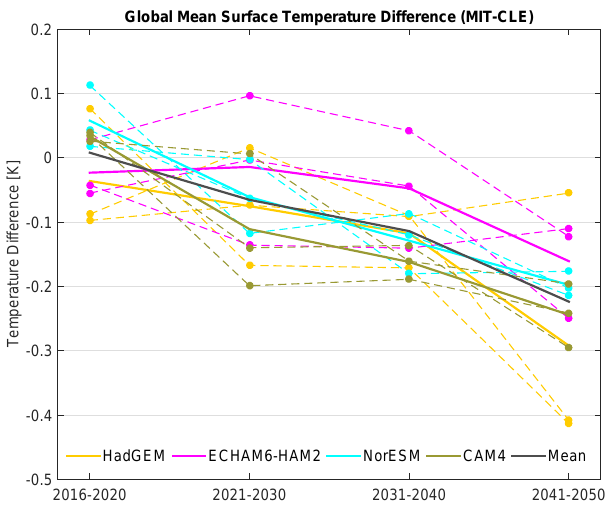
Figure 14. Time evolution of differences in global-mean surface temperature between transient simulations following the mitigation (MIT) and the current legislation (CLE) scenario, i.e. (MIT–CLE), for the four ECLIPSE models. Negative values mean that tempera- tures are lower in the MIT than in the CLE scenario. The ensemble means for each model are shown as thick lines, whereas the individ- ual ensemble members are shown with thin